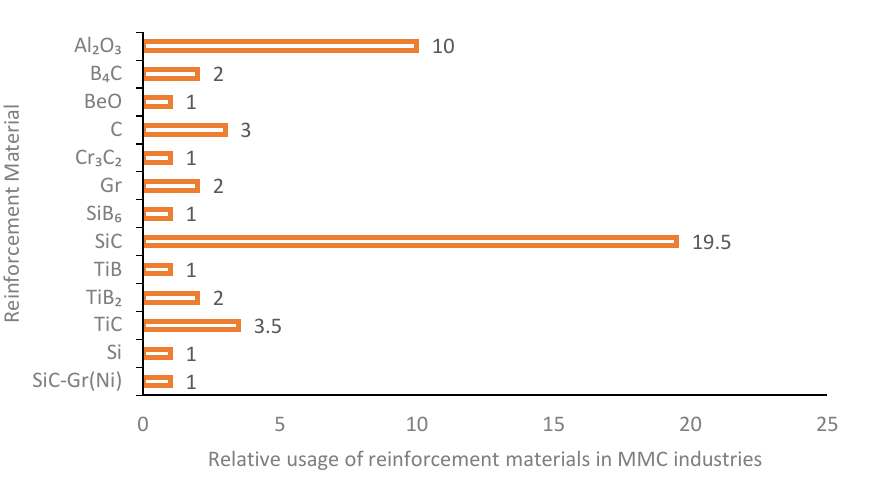
Figure 1: Industrial usage of reinforcement materials (Odiwo et al.,